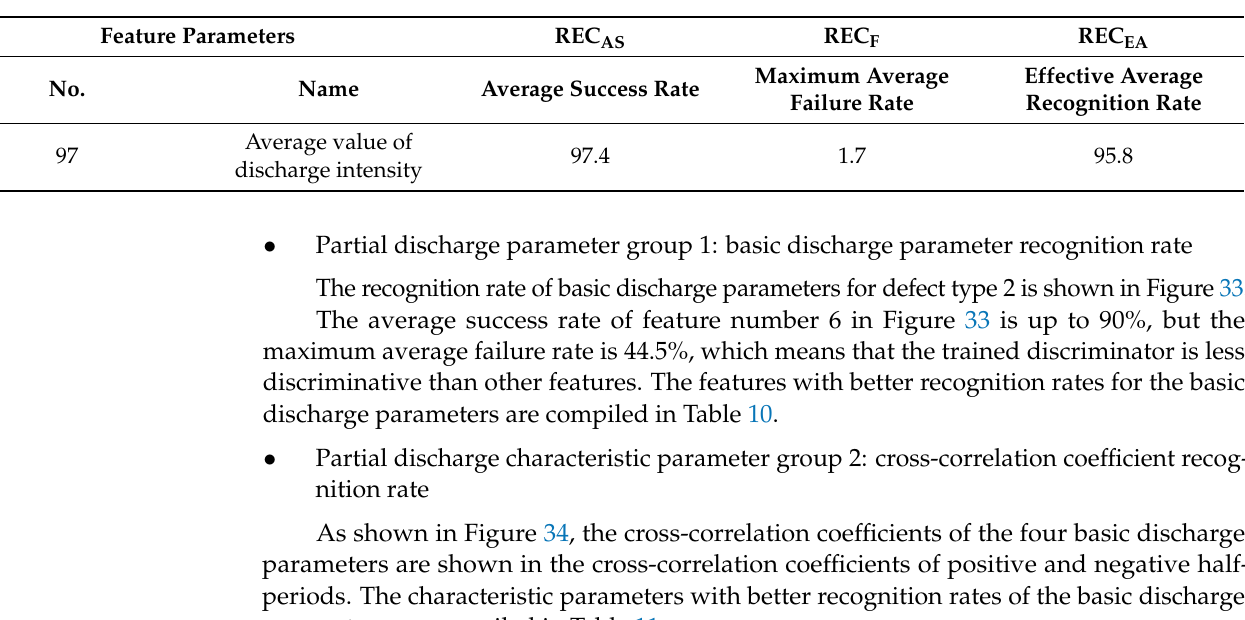
Table 12. GIS-2 better recognition rate of the characteristic parameters: discharge intensity